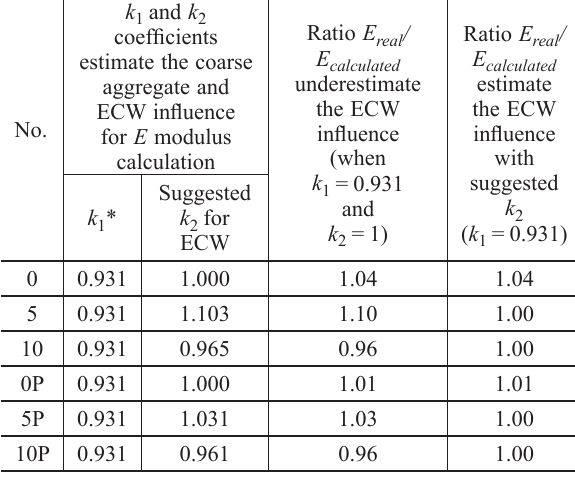
Table 2. Correction factors for coarse aggregate and ECW k 1 and k 2